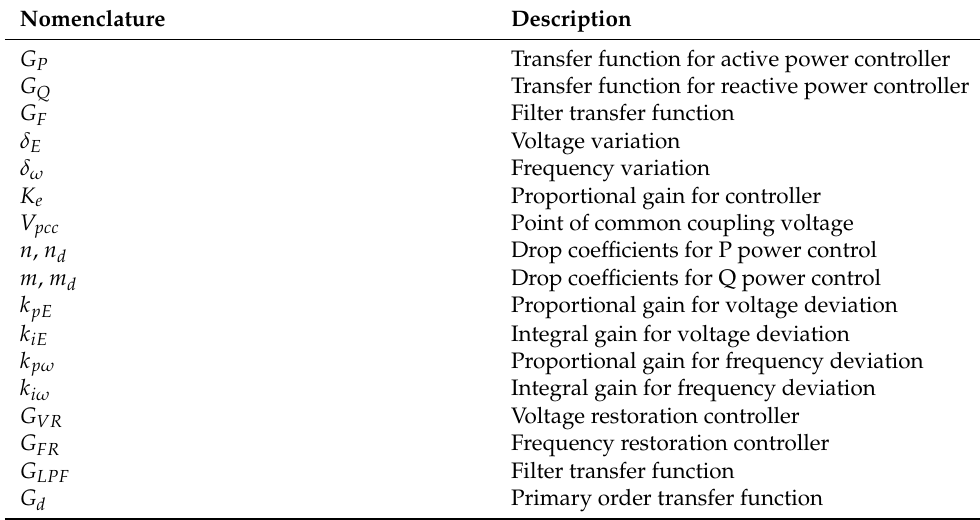
Table 2. Parameters and variables for secondary and tertiary control.